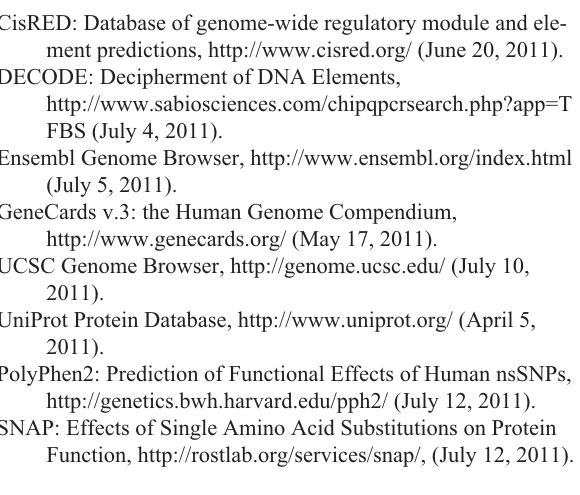
- Table S1 - Orthologues of genes in the NTAD clus- ter in 48 available vertebrate genomes. - Table S2 - Transcription factors predicted by DECODE as regulators of the NTAD genes in humans. - Figure S1 - NTAD cluster in the human